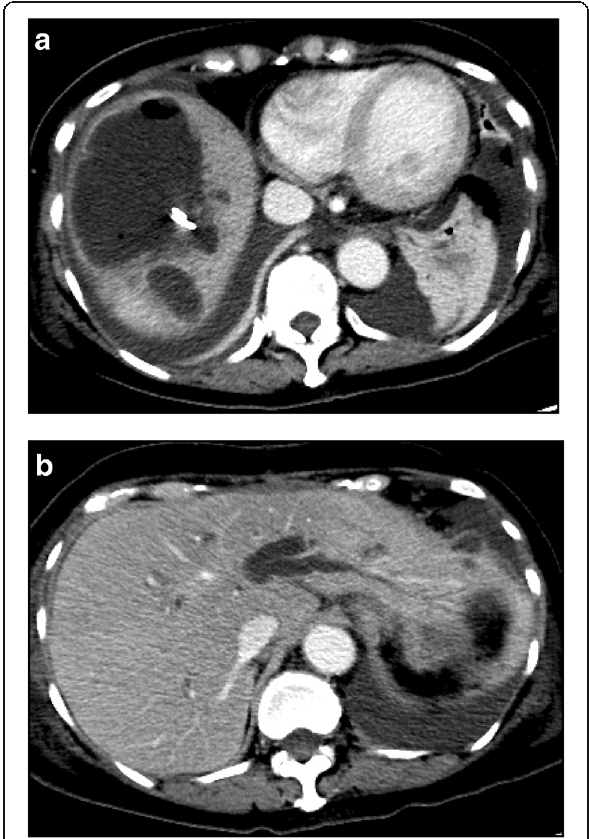
Fig. 5 Contrast-enhanced multidetector CT at POD 65 showing severe hepatic cytolysis ( a ) and choledochojejunostomy stenosis ( b